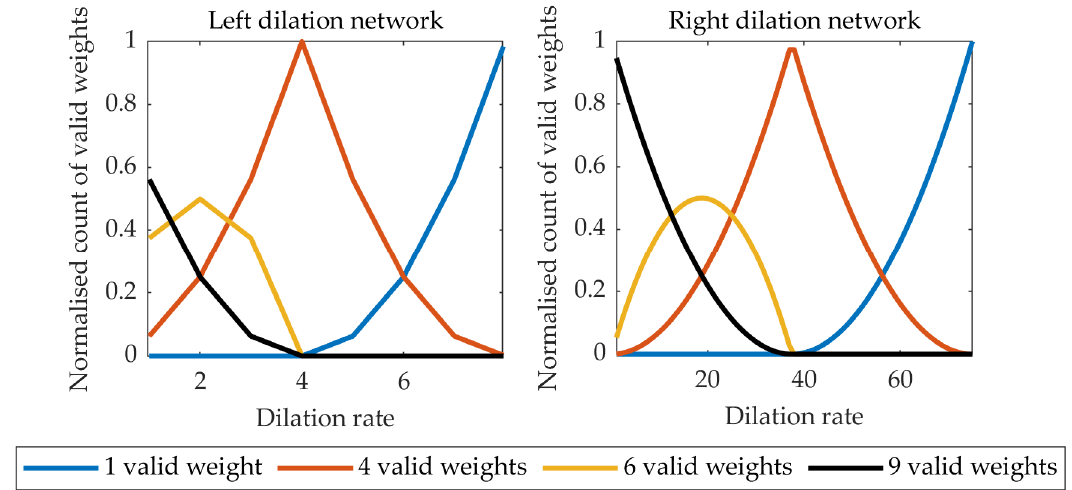
Figure 4. The count of valid weights in the dilation kernel for the left and right classification sub-networks in Figure 2.